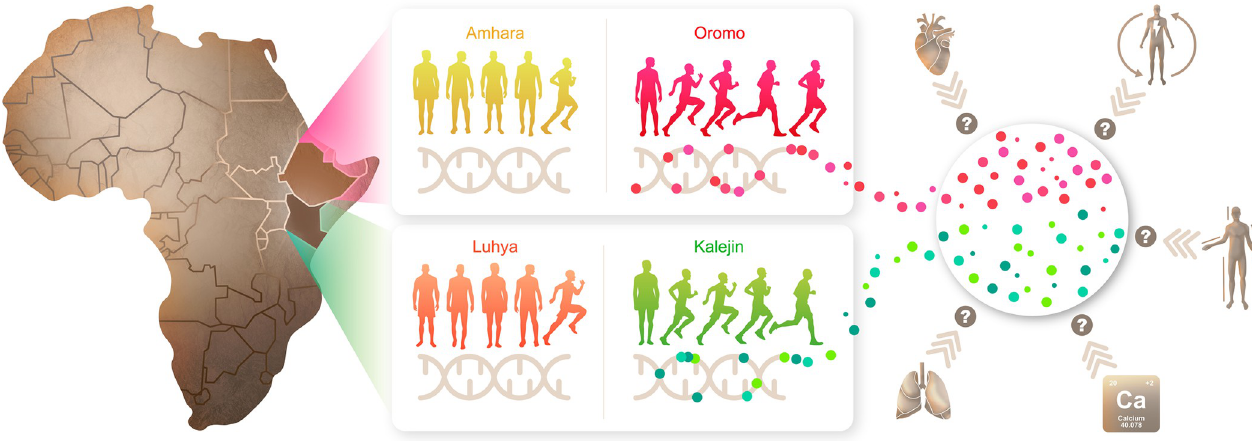
Fig 2. Overview of the study design. For each country, Ethiopian and Kenya, ethnicities overrepresented among endurance running athletes, Oromo and Kalenjin, respectively, were compared to populations that are underrepresented among athletes, Amhara and Luhya, respectively. Note that all populations may contain individuals that are genetically predisposed to endurance running or not, though in different proportions. Population comparisons allowed the identification of genome regions highly differentiated in Oromo and Kalenjin and the genes in their vicinity. The list of genes was then interrogated for enrichment for phenotypic traits that may be relevant for endurance running, such as heart function, energy metabolism, anthropometric traits, calcium homeostasis, and lung function, among others. Please see the Methods for a detailed description of all steps performed during the study.